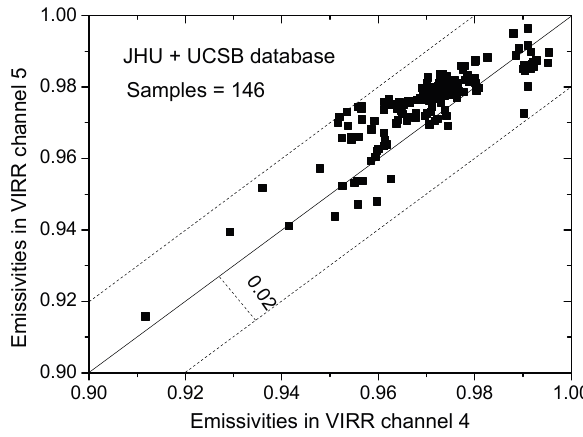
Figure 3. Value of emissivity and range of emissivity differences between VIRR Channels 4 and 5. JHU, Johns Hopkins University; UCSB, University of California Santa